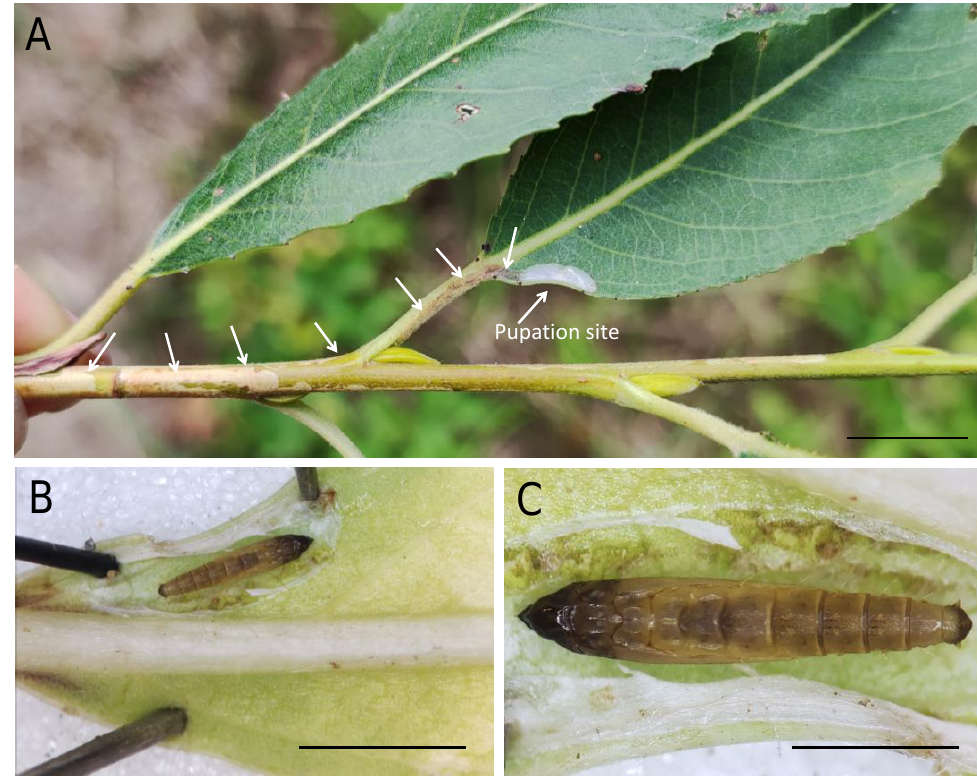
Figure 9. The mines of Phyllocnistis ramulicola on Salix cinerea ( A ) and S. alba ‘Aurea’ ( B , C ) found in the Volčji Potok Arboretum, Slovenia, 9 August 2022 . ( A ) a long tunnel (shown by arrows) in the twig and the pupation site at the leaf base (indicated); ( B , C ) a pupation site on the lower side of the leaf near the leaf base with the pupa. Scale: ( A ) 20 mm; ( B ) 5 mm; ( C ) 2 mm. Photo: N.I. Kirichenko, S. Gomboc.